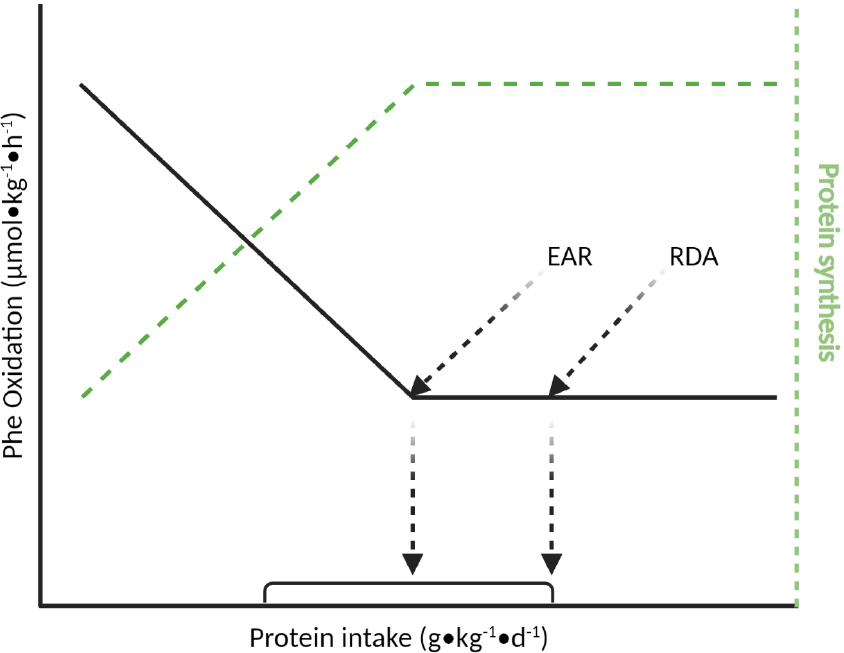
Figure 1. Adapted from Elango et al. [4]. As protein intake increases, so does the limiting amino acid and the oxidation of the indicator amino acid. This represents an increase in the incorporation of the indicator amino acid into newly synthesized proteins. A plateau in the oxidation of the indicator amino acid represents a maximal rate of incorporation in proteins. The breakpoint represents the estimated average requirement (EAR) for 50% of the population. The recommended dietary allowance (RDA) can be calculated as either 2 SD above the mean or the upper 95% CI. Created with BioRender.com.